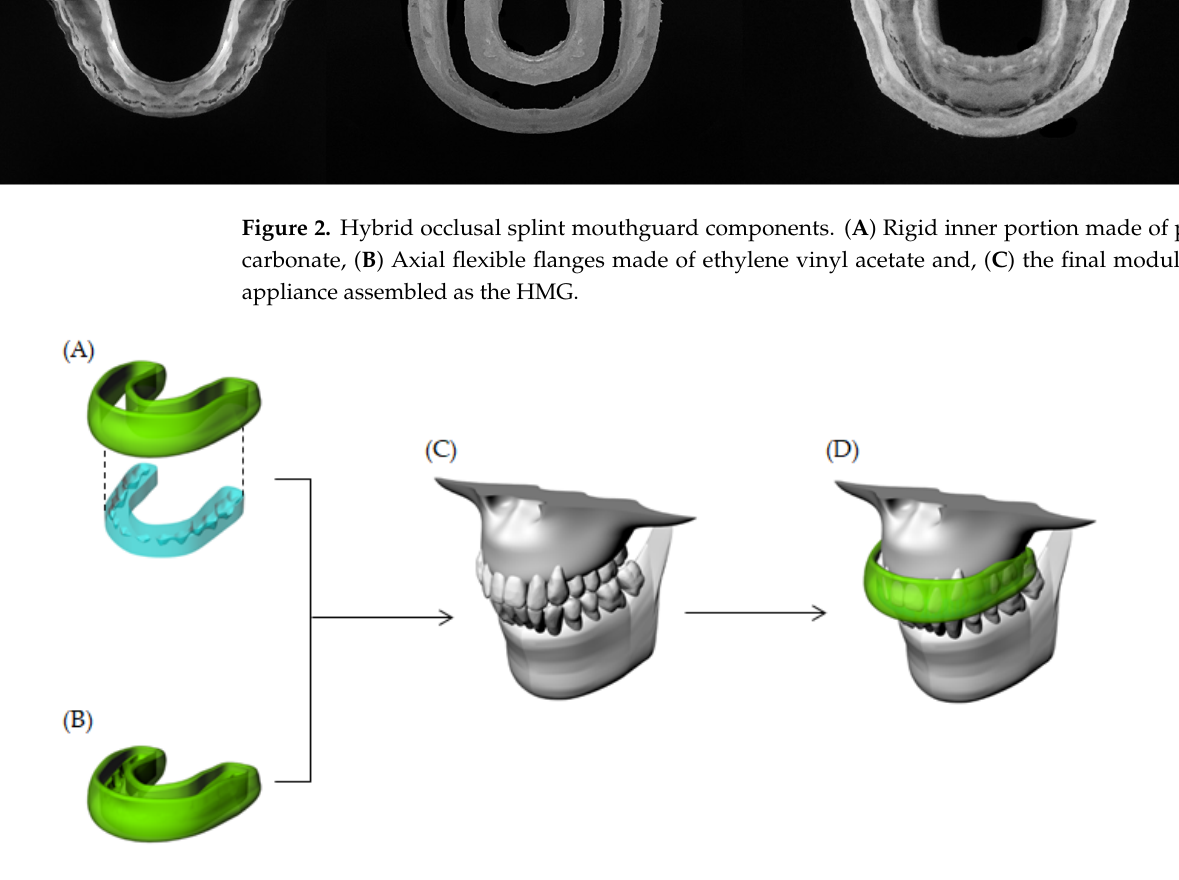
Figure 2. Hybrid occlusal splint mouthguard components. ( A ) Rigid inner portion made of polycarbonate, ( B ) Axial flexible flanges made of ethylene vinyl acetate and, ( C ) the final modulated appliance assembled as the HMG.